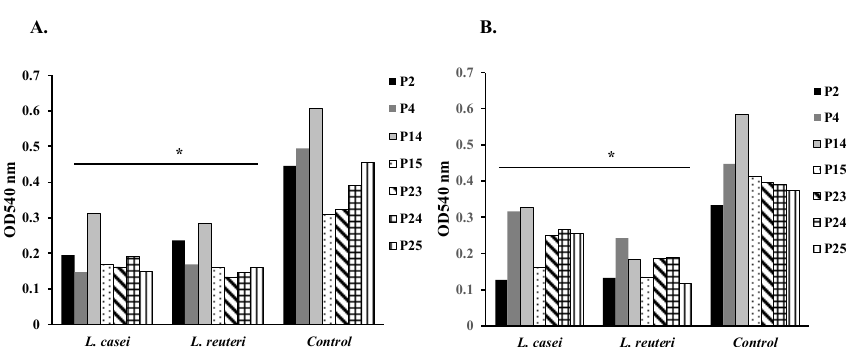
Figure 1. E ff ect of supernatants of L. casei and L. reuteri on mature biofilm formation of Proteus mirabilis isolates P2, P4, P14, P15, P23, P24, and P25 (* p < 0.05). ( A ) E ff ect of untreated supernatants of L. casei and L. reuteri on mature biofilm formation of Proteus mirabilis isolates P2, P4, P14, P15, P23, P24, and P25 (* p < 0.05). ( B ) E ff ect of treated supernatants of L. casei and L. reuteri on mature biofilm formation of Proteus mirabilis isolates P2, P4, P14, P15, P23, P24, and P25 (* p < 0.05).